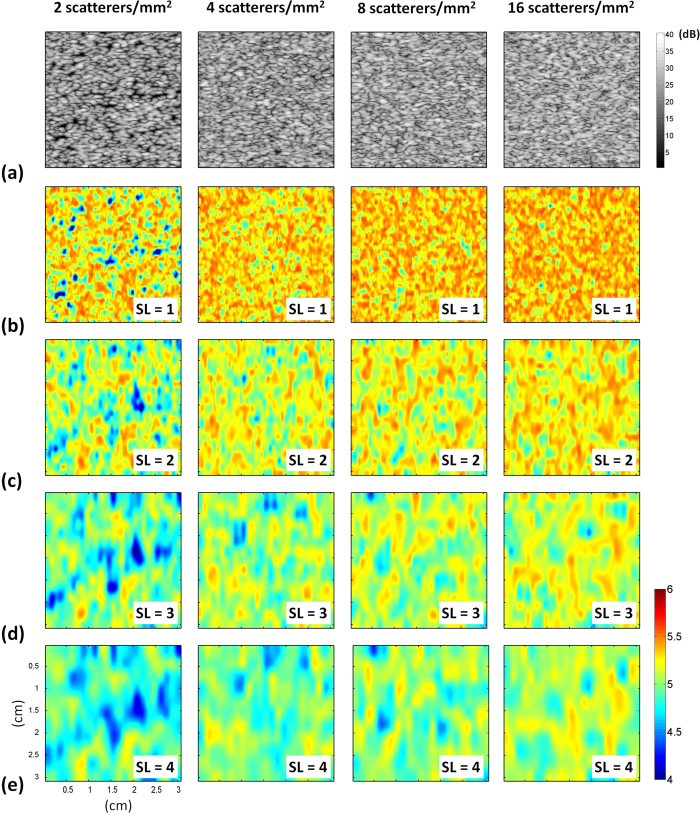
(a) B-mode and (b–e) entropy images of Type-I simulated phantoms with different number densities of scatterers. (b) SL = 1; (c) SL = 2; (d) SL = 3; (e) SL = 4. The dimensions for all images are the same. The grayscale and color bars represent the pixel values (the brightness) of the B-mode and entropy images, respectively. The shade of the entropy image depends on the window size.